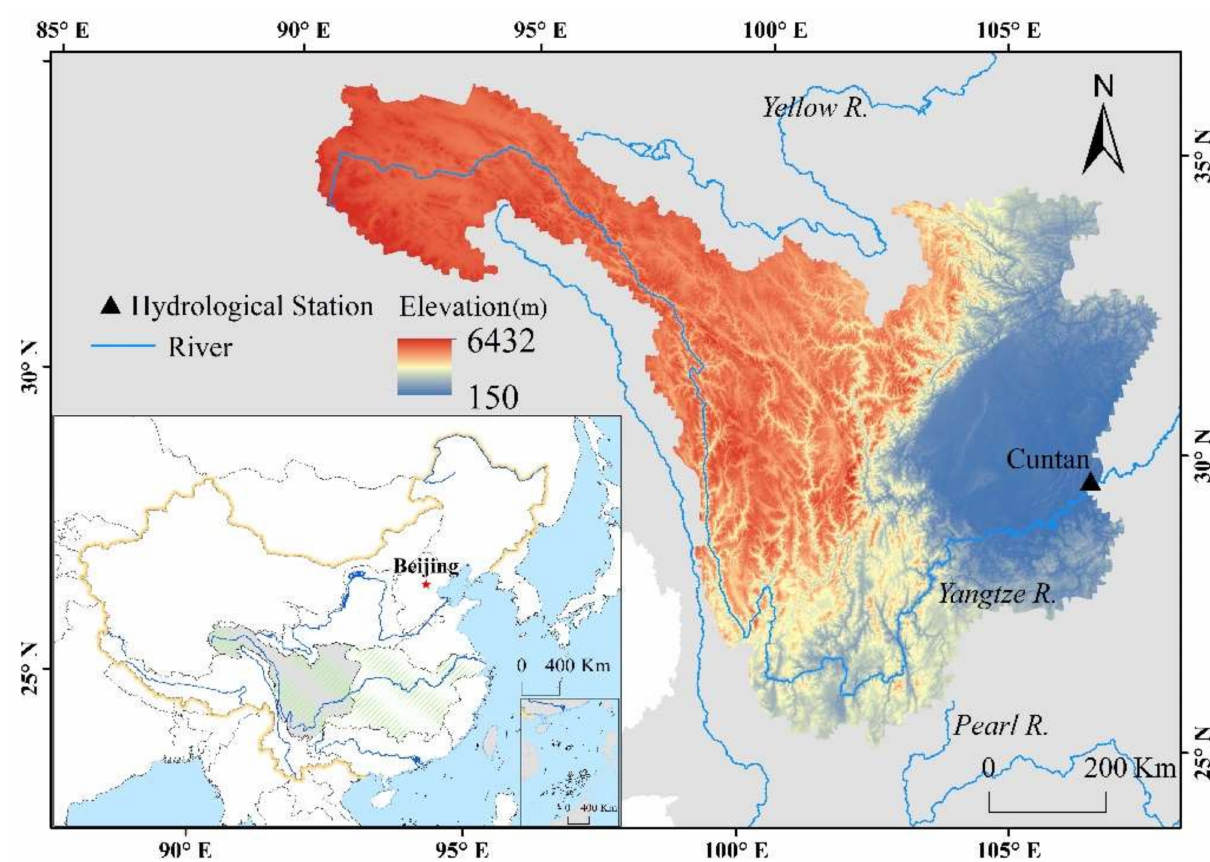
Figure 1. Map of the upper Yangtze River basin and the Cuntan hydrological station in the western